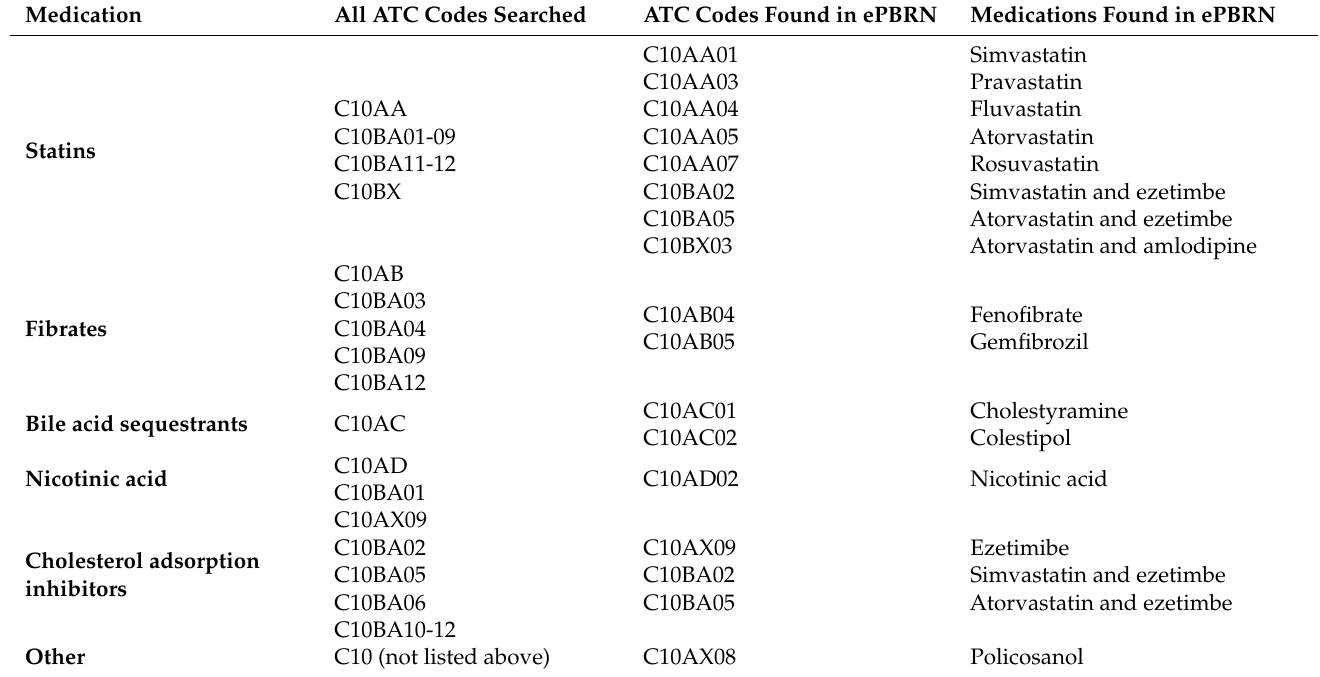
Table A1. Classifications of different lipid-lowering medications based on ATCC